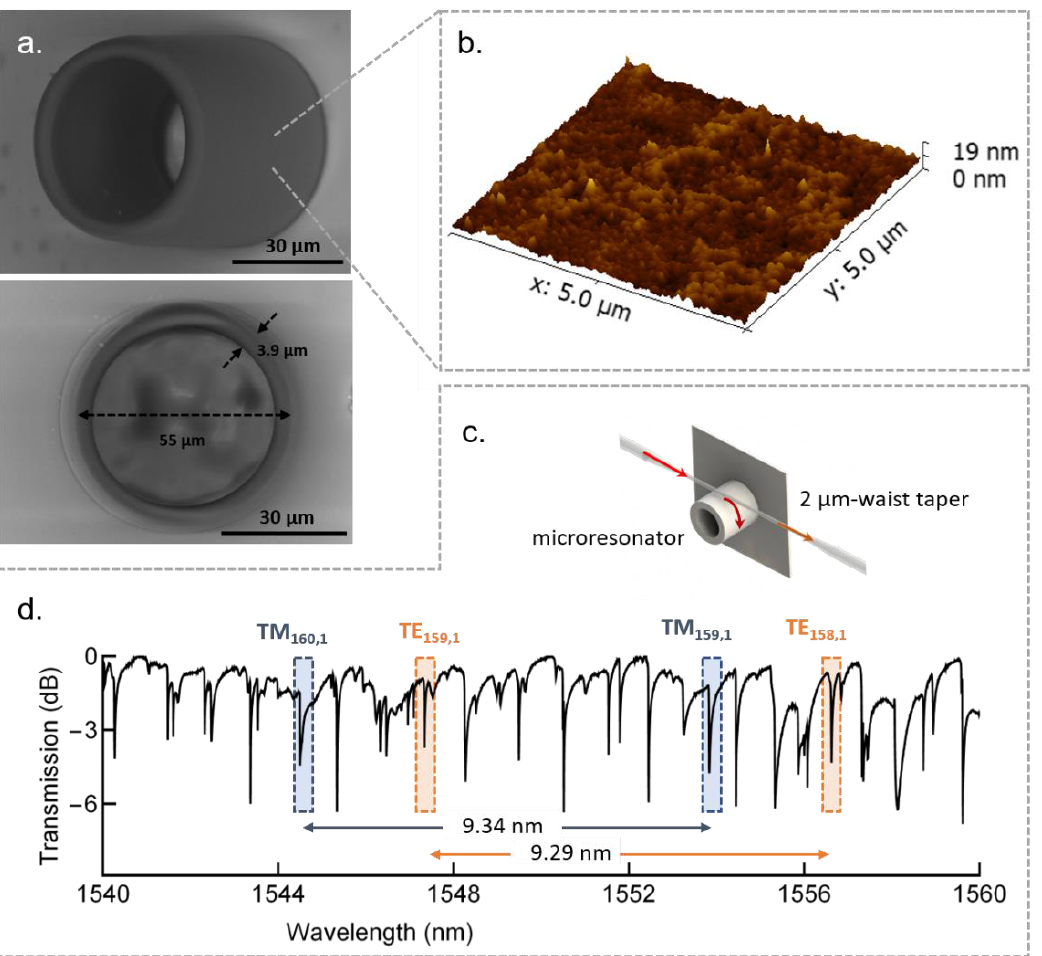
Figure 13. Polymeric microcylinder resonator fabricated by TPP. ( a ) Scanning electron micrographs of the microresonator. ( b ) Atomic force microscopy of the microresonator outer sidewall surface. ( c ) Schematics of the evanescent light coupling to the microresonators through the use of tapered fibers. ( d ) Spectral response of the microresonator. The attenuation peaks represent the WGMs accounting for different azimuthal and radial orders. Highlighted in the figure are the TE and TM fundamental radial WGMs, with their corresponding FSR. Adapted with permission [17]. Copyright © 2017, John Wiley and